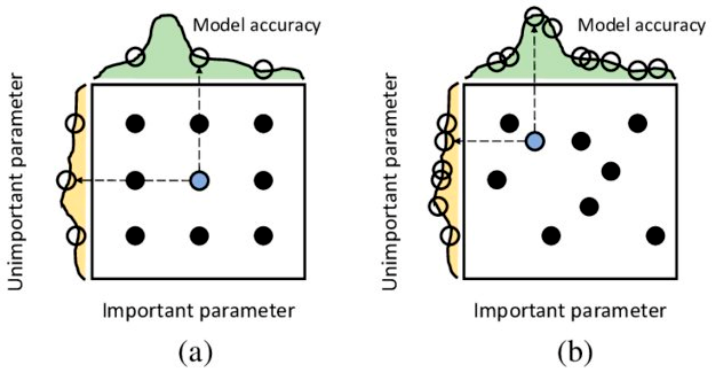
Figure 6. Comparison between ( a ) grid search and ( b ) random search for hyper-parameter tuning [50].